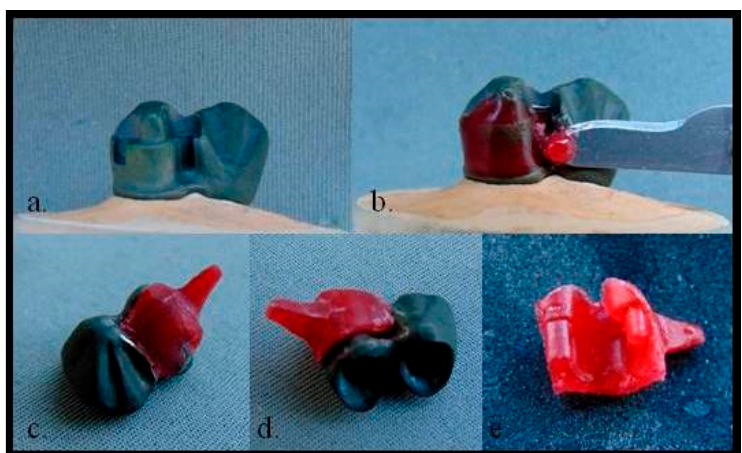
Figure 8. ( a ). Pa framework; ( b ). Deposition of resin material on the assembly surface of the Pa framework; ( c ) Making the handle and setting of the material; ( d ) Detachment by traction of the resin model from the assembly surface; ( e ) Framework resin model of the detached Pb framework (indicating a non-retentive assembly surface).